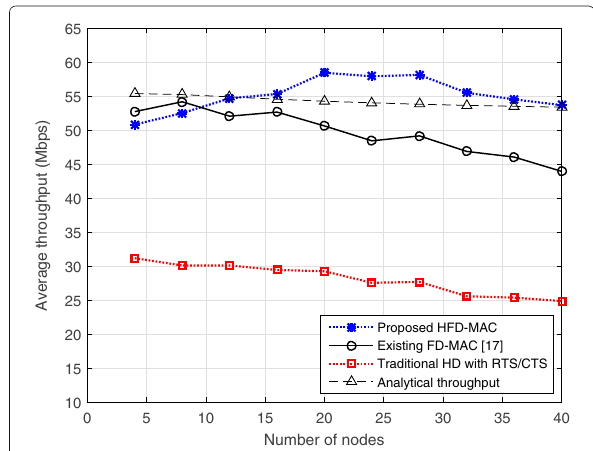
Fig. 12 Average throughput with respect to number of nodes